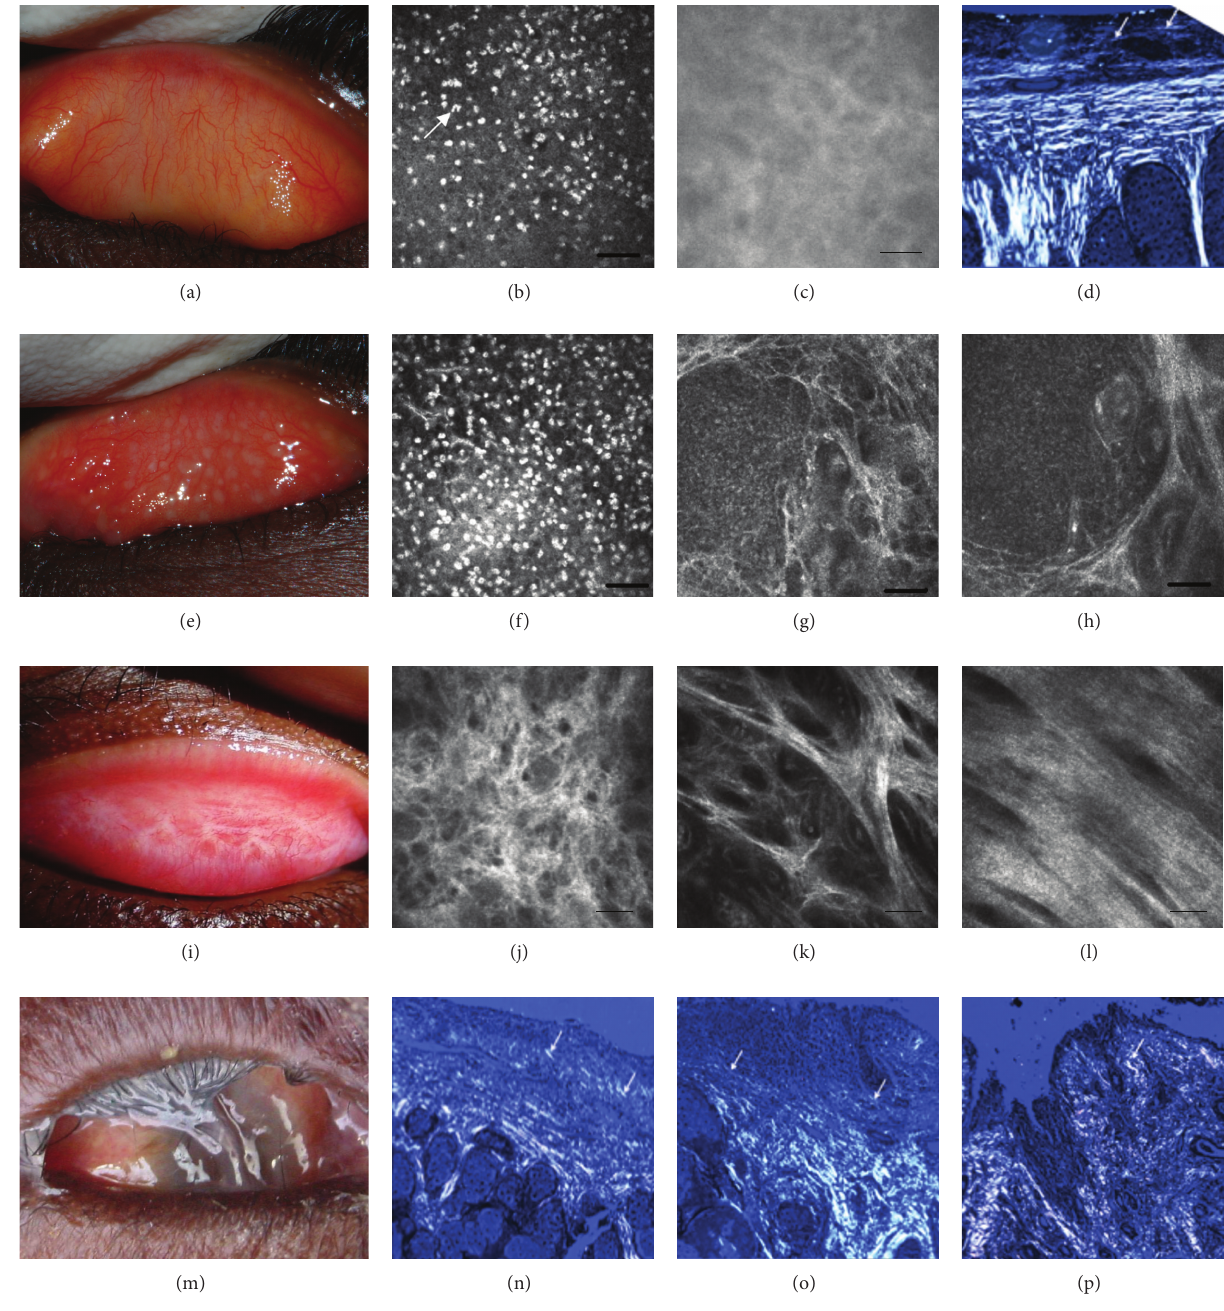
Figure 1: Images from a normal healthy eye (a–d) and from individuals with follicular trachoma (e–h), trachomatous scarring (i–l), and trichiasis and progressive scarring (m–p). (a), (e), (i), and (m) are photographs of the tarsal conjunctiva showing normal appearance (a), papillary inflammation and follicles (e), bands of trachomatous scarring (i), and extreme trichiasis and corneal opacity (m). (b), (c), (f), (g), (h), (j), (k), and (l) are in vivo confocal microscopy images of the tarsal conjunctiva at various depths (the bar represents 50 𝜇 m). A moderate number of inflammatory nuclei are present in the subepithelium of a healthy eye (b), whereas a higher number are present in trachomatous inflammation (f). Follicles can be seen in (g) and (h). The connective tissue of the healthy conjunctiva is amorphous (c), whereas successive grades of trachomatous scarring are seen as a heterogeneous clumpy appearance (j), defined tissue bands that make up < 50% of the scan area (k), and defined bands that make up > 50% of the scan area (l). (d) and (n–p) are histological images of tissue scarring using polarized light (original magnification × 100). In the healthy conjunctiva, collagen fibers are parallel (arrows) with the surface epithelium (d), whereas progressive disorganization of this appearance is observed in scarring (n–p). Images are kindly provided with permission from Matthew Burton and Victor Hu and are adapted from Hu et al. 2011 [11] and Hu et al. 2013